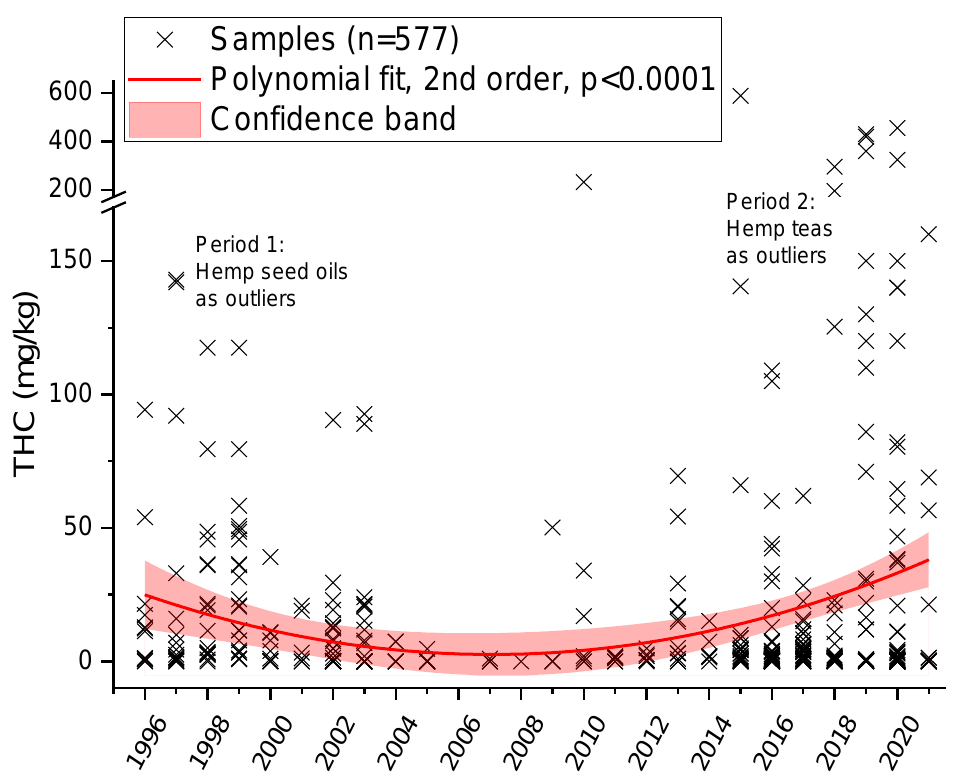
Figure 3. Time trend of the ∆ 9 -tetrahydrocannabinol (THC) content in hemp food products, except hemp food supplements, in the years 1996 to the first half of 2021 (note: data before 2008 are total- THC).